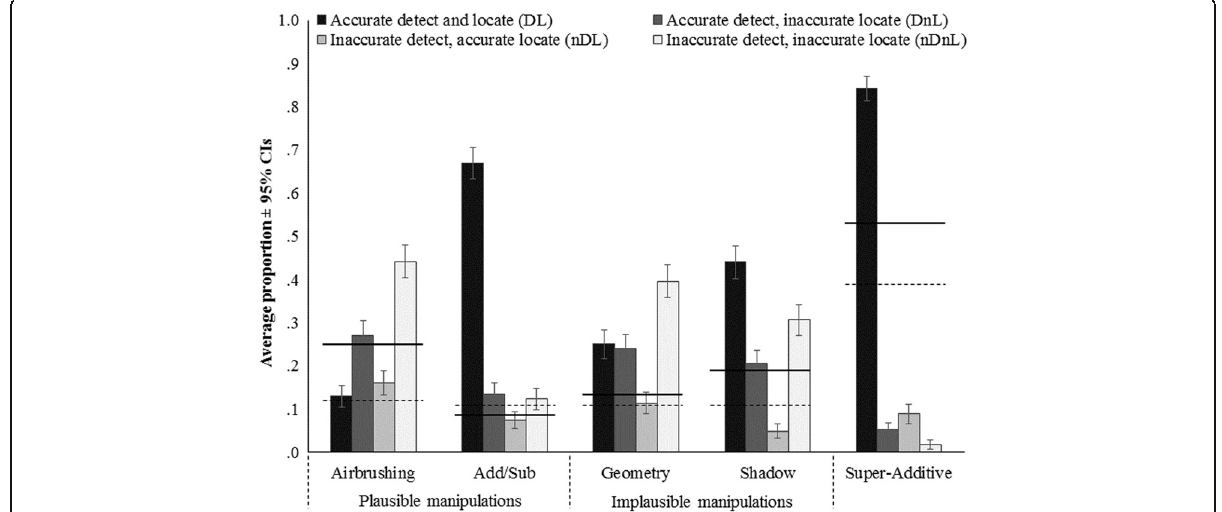
Fig. 7 Mean proportion of manipulated photos accurately detected and accurately located (DL), accurately detected, inaccurately located (DnL), inaccurately detected, accurately located (nDL), and inaccurately detected, inaccurately located (nDnL) by manipulation type. The dotted horizontal lines on the bars represent chance performance for each manipulation type from the results of the Monte Carlo simulation. The full horizontal lines on the bars represent chance performance for each manipulation type based on subjects ’ responses on the original image trials. Error bars represent 95% CIs